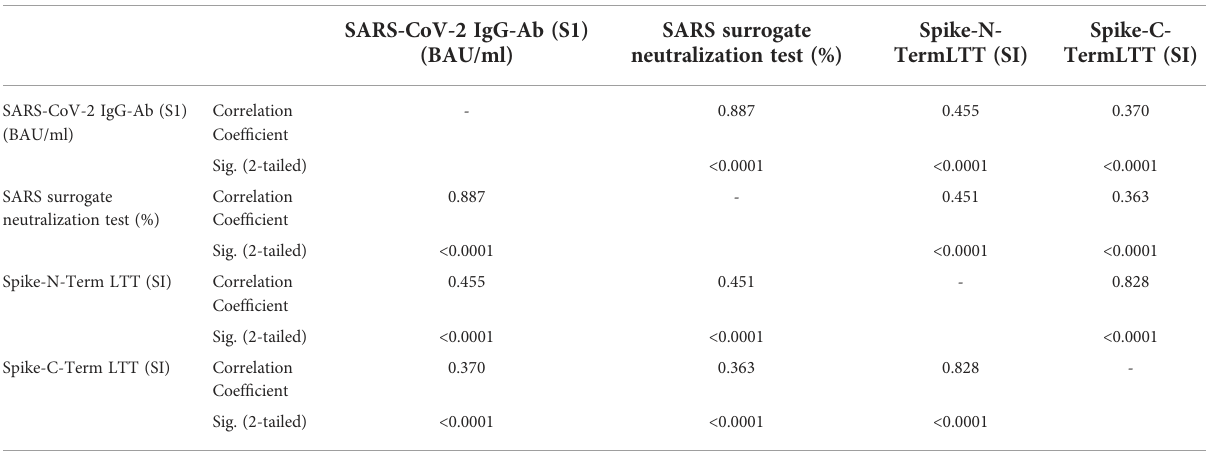
TABLE 4 Bivariate associations between humoral and cellular response parameters.